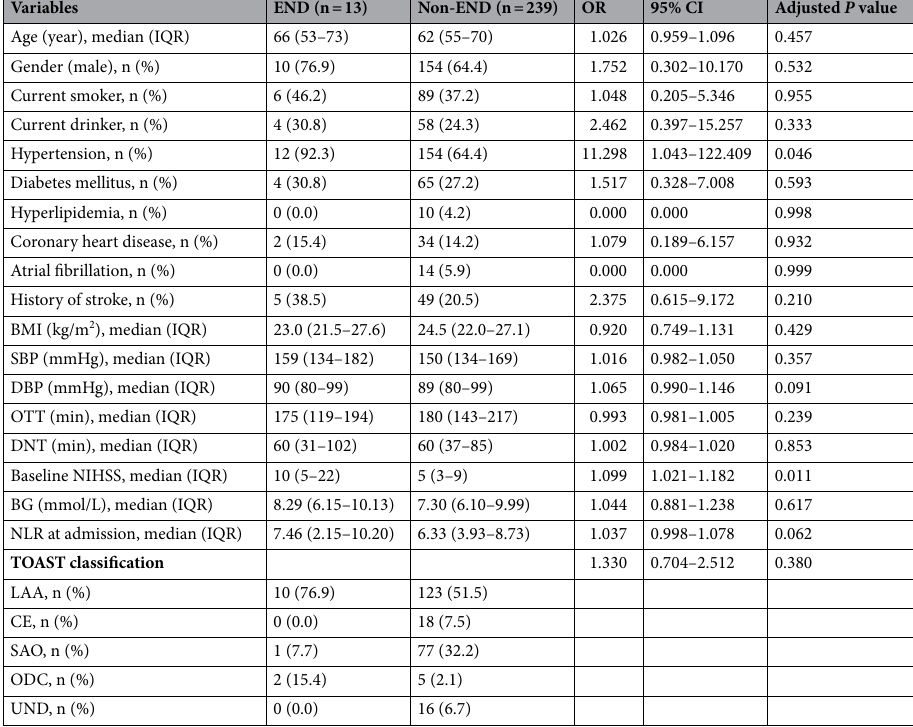
Table 3. Multivariate logistic regression analysis on associated factors in PCS group. BG blood glucose, BMI body mass index, CE cardioembolism, DBP diastolic blood pressure, DNT door to needle time, END early neurological deterioration, IQR interquartile range, LAA large-artery atherosclerosis, NIHSS National Institute of Health Stroke Scale, NLR neutrophil-to-lymphocyte ratio, ODC stroke of other determined cause, OTT symptom onset to thrombolysis time, PCS posterior circulation stroke, SAO small-artery occlusion, SBP systolic blood pressure, TOAST trial of Org 10,172 in acute stroke treatment, UND stroke of undetermined